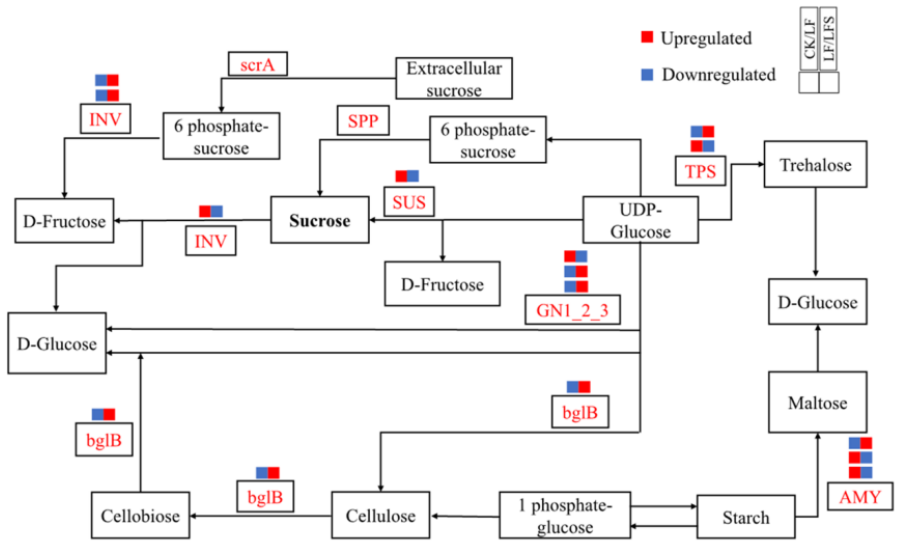
Figure 7. Diagram of plant sucrose metabolism pathway.